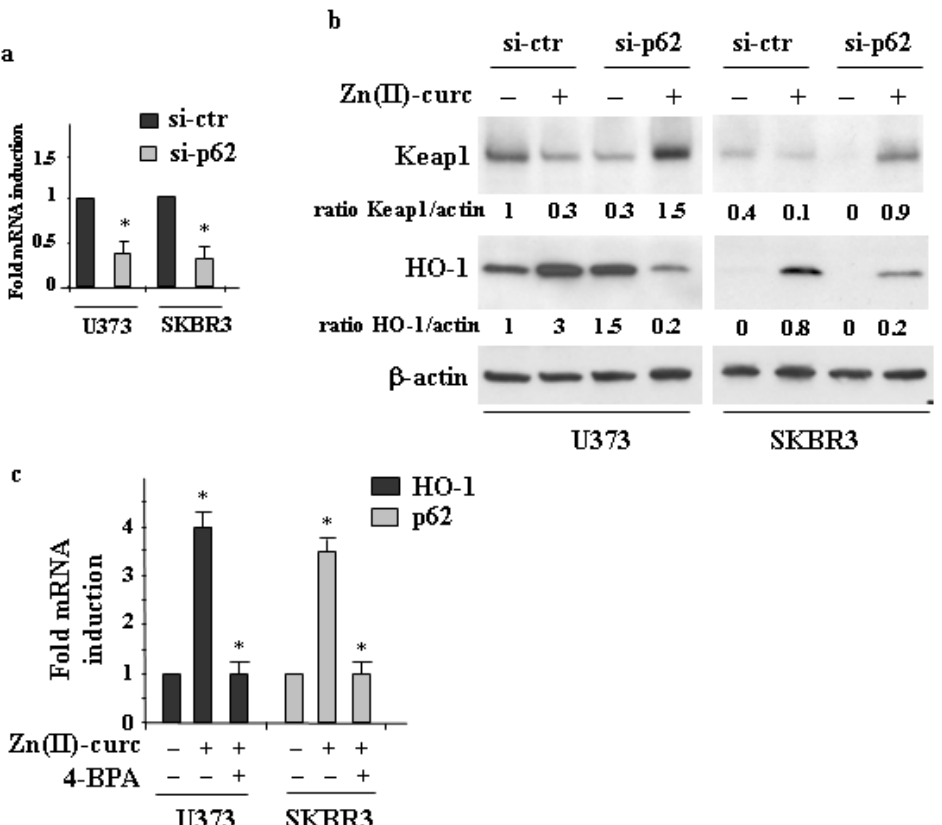
Figure 3. p62 silencing impairs NRF2 activation. ( a ) U373 and SKBR3 cells were transfected with siRNA control (si-ctr) and sip62 and 36 h after transfection assayed for RT-PCR of p62 gene expression. Densitometric analysis was performed using Image J software to calculate p62 gene expression/28S ratio. ( b ) U373 and SKBR3 cells, transfected with siRNA control (si-ctr) and sip62 and 36 h, were then treated with Zn–curc (100 μg/mL) for 24 h before Western blot analysis of the indicated proteins. Actin was used as protein loading control. The ratio of the proteins level vs. β -actin, following densitometric analysis using Image J software, is reported. ( c ) U373 and SKB3 cells were treated with Zn(II)–curc (100 μg/mL) for 24 h, with or without 1 h pre-treatment with 4-BPA (2.5 mM) before assaying for RT-PCR analyses of gene expression. Densitometric analysis was performed using Image J software to calculate the p62 or HO-1/28S ratio. Histograms represent the mean ± SD of three independent experiments. * p ≤ 0.05.